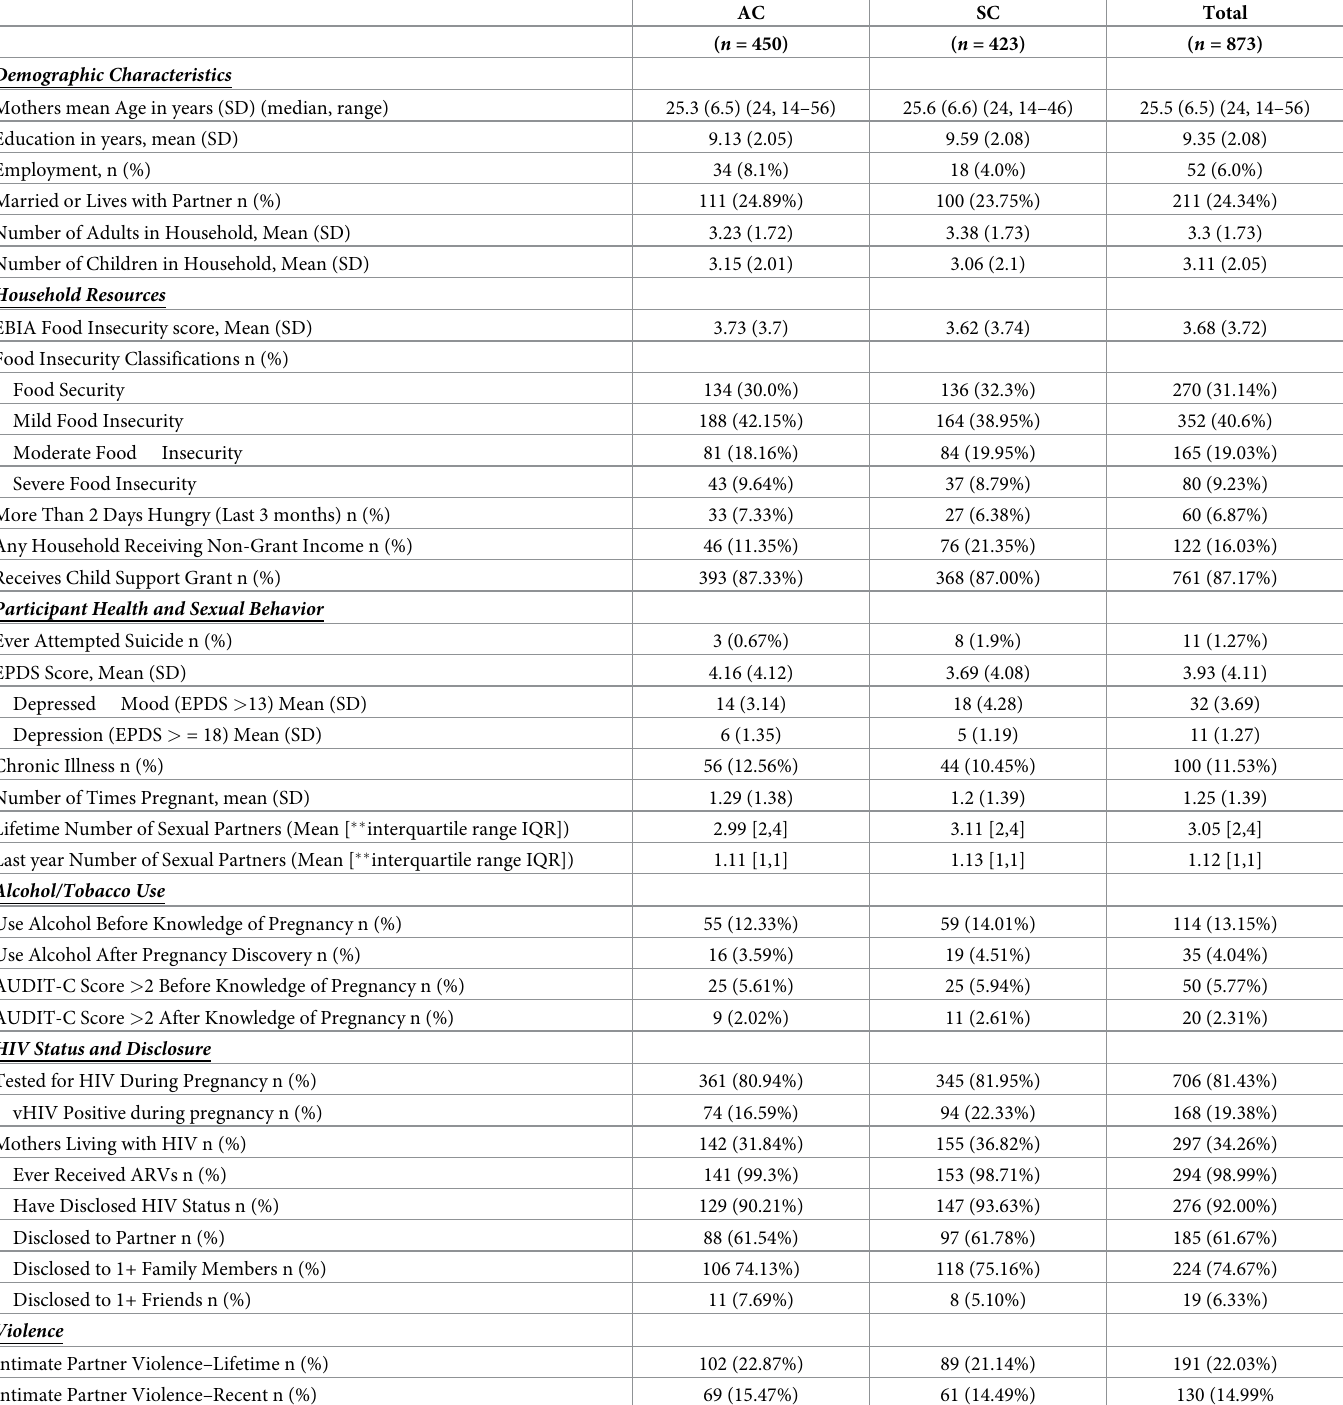
Table 2. Baseline characteristics of the sociodemographic characteristics and risk characteristics of the sample grouped by the Accountable Care (AC), Standard Care (SC) conditions, and Overall